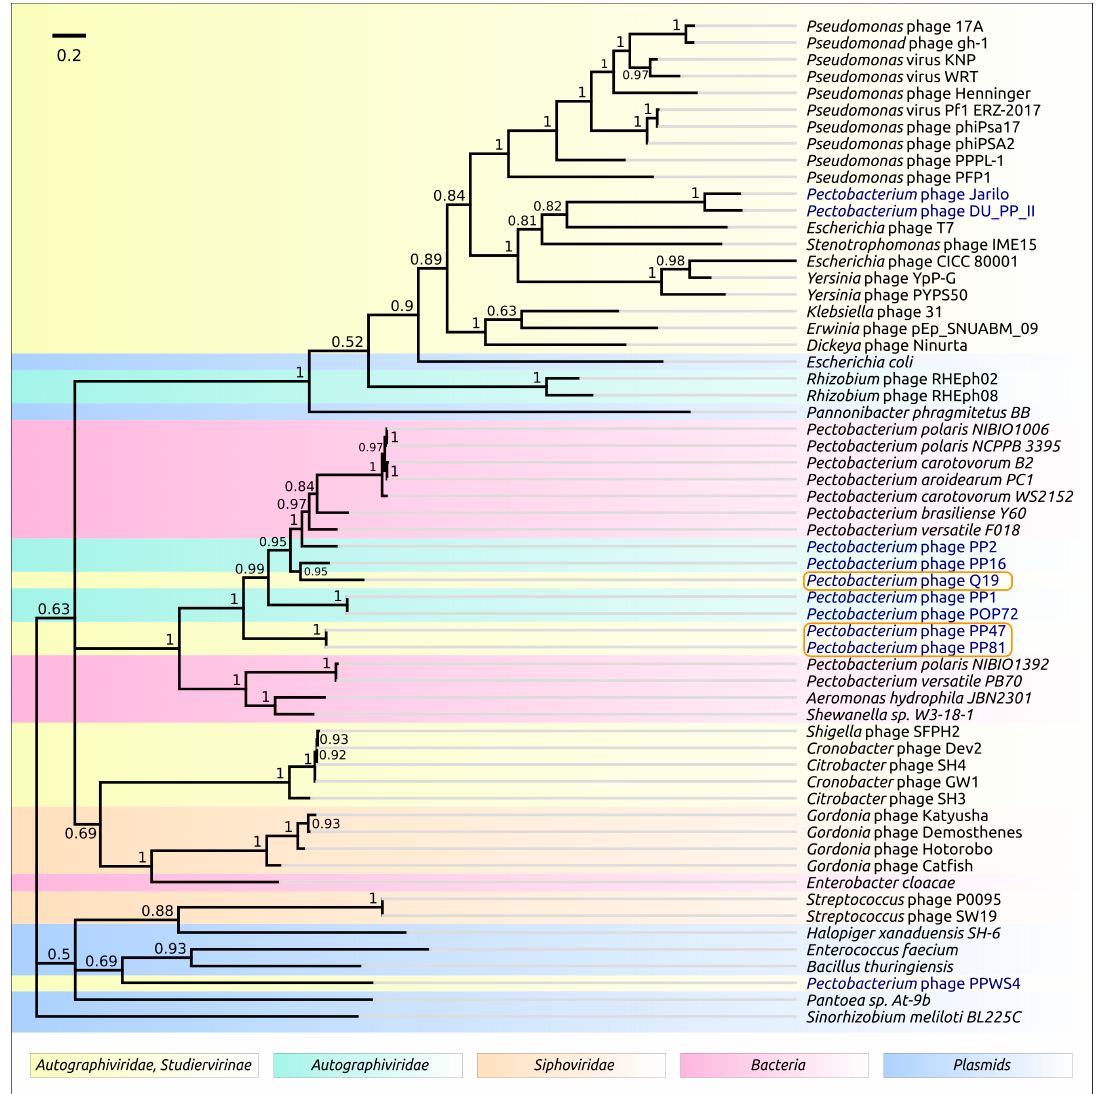
Figure 11. Phylogenetic tree obtained with MrBayes, based on amino acid sequences of the central domain of tail fibre/tail spike proteins and homologous sequences obtained by a BLAST search of Genbank phage and bacterial databases. Bayesian posterior probabilities are indicated above their branch. The scale bar shows 0.2 estimated substitutions per site and the tree was rooted to Sinorhizobium meliloti BL225C plasmid; of 2,000,000 generations, 200 generations were sampled, with an average standard deviation of split frequencies of 0.0062.